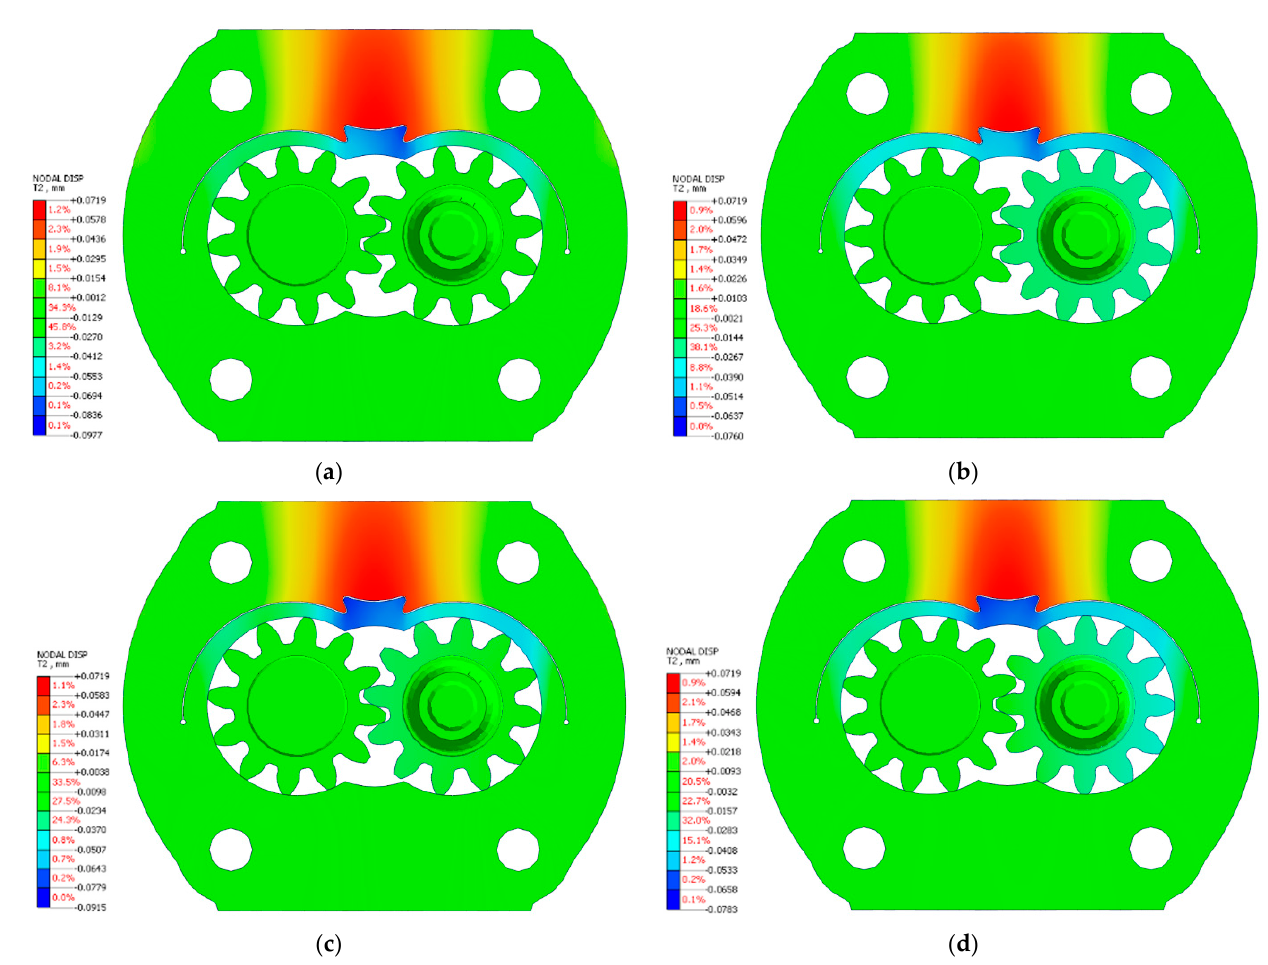
Figure 14. Distribution of displacements in the Y-axis in casing D, gear rotation angle: ( a ) 0°, ( b ) 7.5°, ( c ) 15°, ( d ) 22.5°. ( c ) 15 ◦ , ( d ) 22.5 ◦